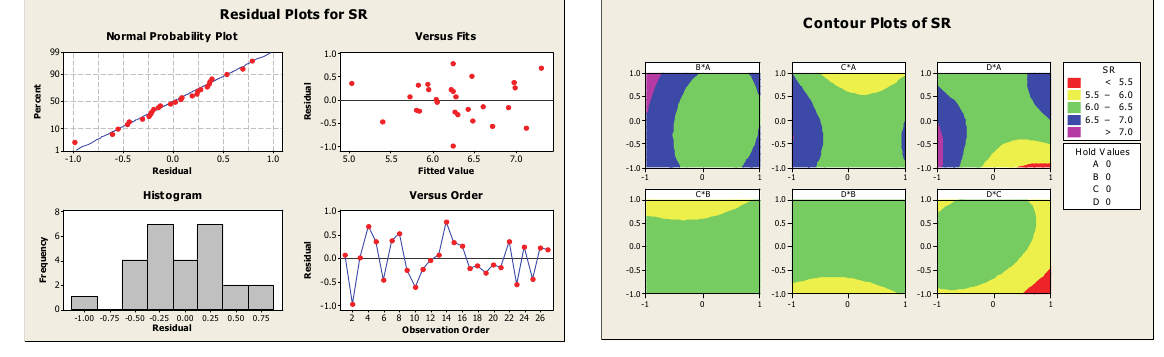
Fig. 5. Residual plots of SR Fig. 6. Contour Plots of